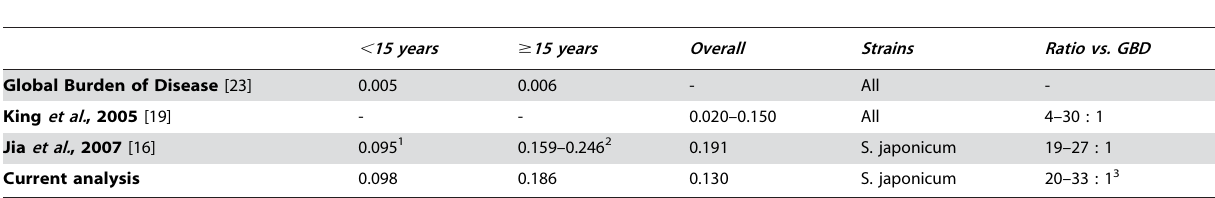
Table 3. Disability weight estimates from review studies of all schistosome strains and schistosomiasis japonica